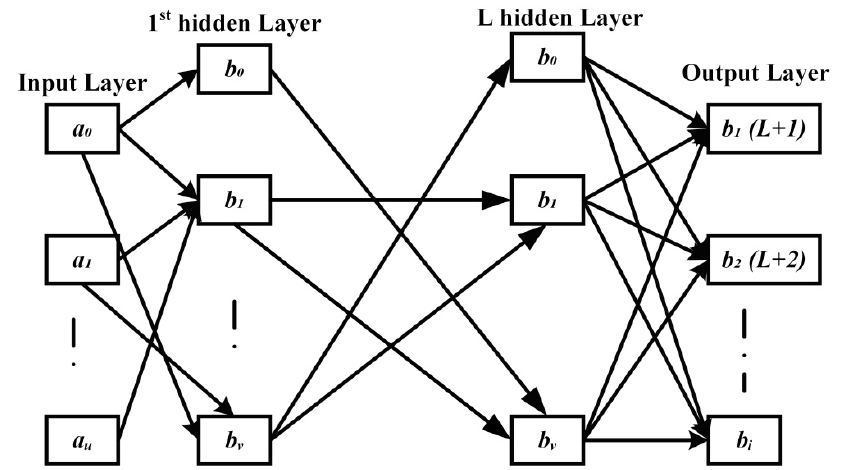
Figure 3. Multi-layer perceptron network graph layer.